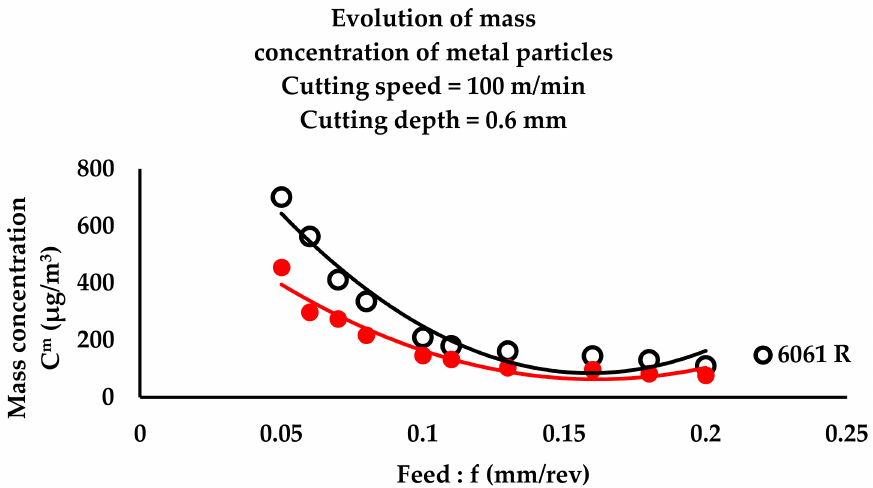
Figure 9. Evolution of the mass concentration of metal particles as a function of the feed during machining with lubrication of recycled alloys 6061 R and